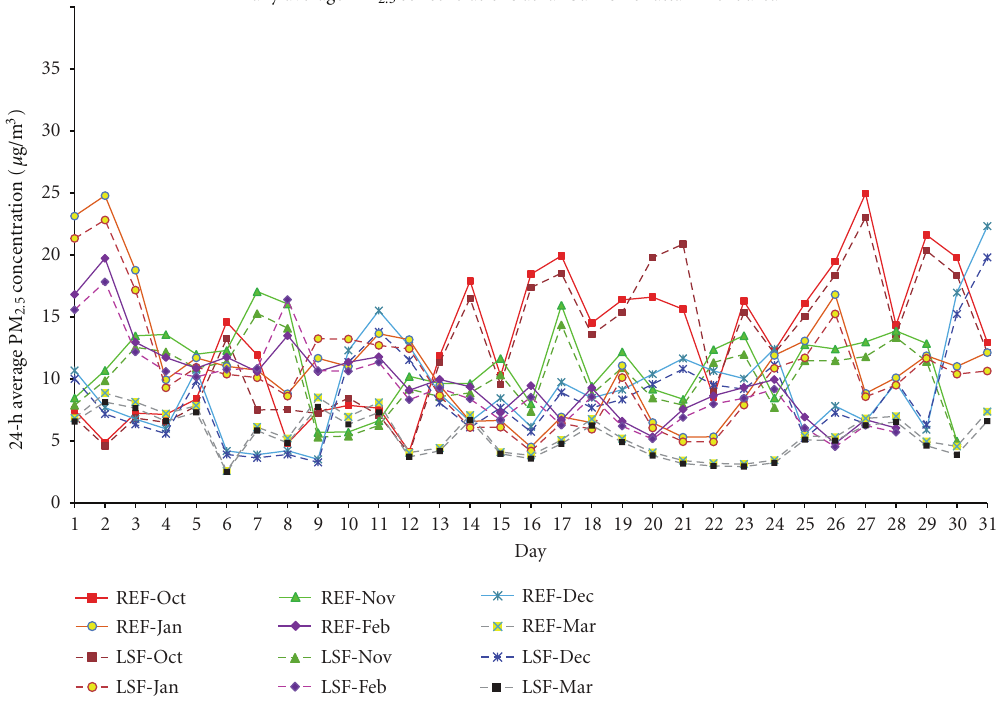
Figure 4: Temporal evolution of simulated 24h-average PM 2 . 5 concentrations averaged over the nonattainment area for October to March as obtained by REF and